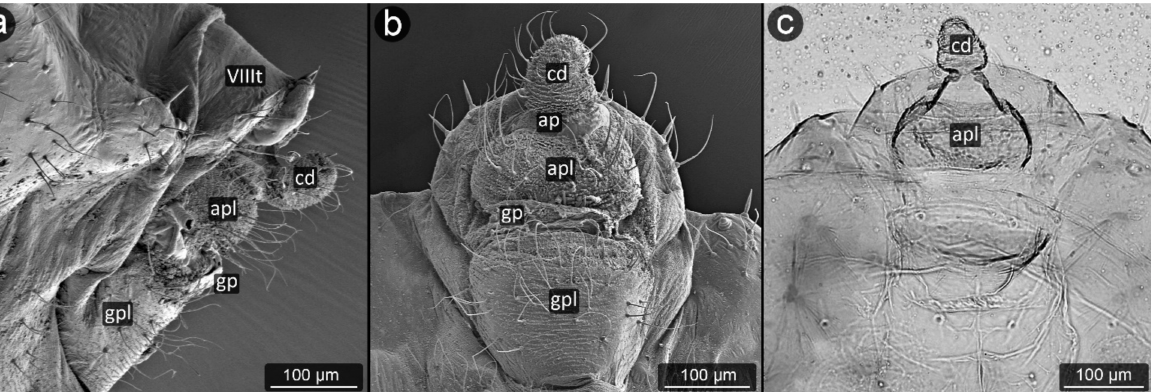
Figure 20. Perianal structure of Thelaxes dryophila ; ( a )—lateral view (SEM), ( b )—rear view (SEM), ( c )—rear view in light microscopy.